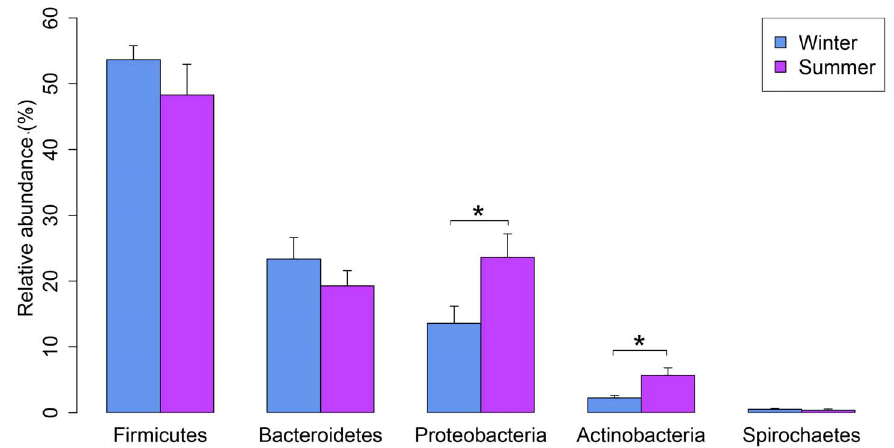
Figure 2. Relative abundance (means ± SE) of the most abundant bacterial phyla detected in SCBs bioaerosol during the winter and summer seasons. * indicates significantly different at . 0.05.